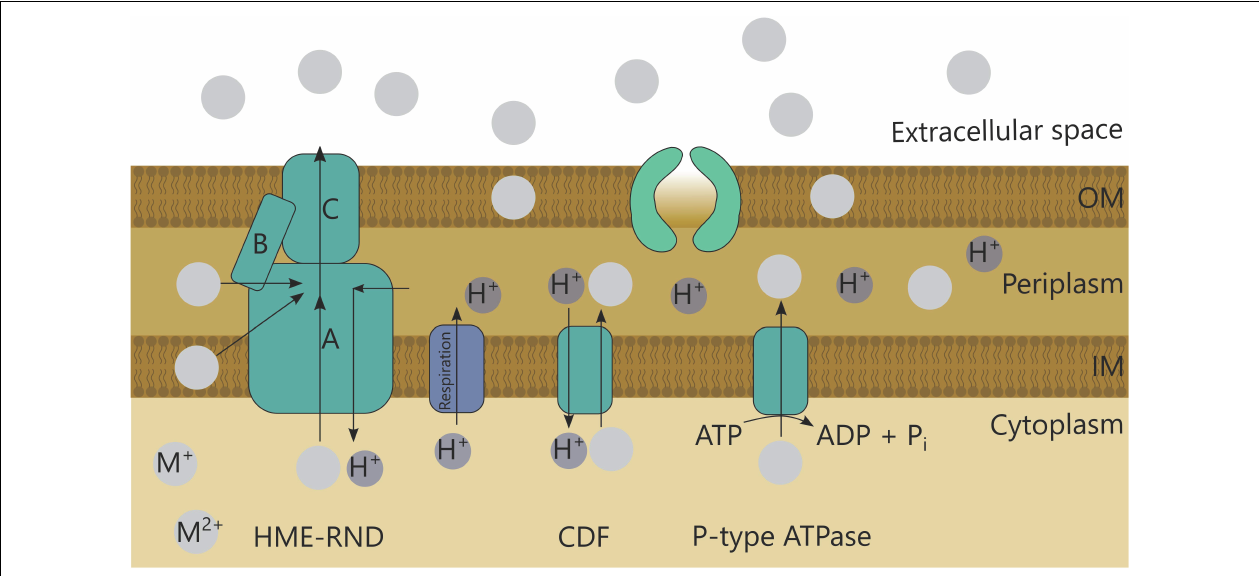
FIGURE 3 | Overview of bacterial efflux systems HME-RND, CDF, and P-type ATPase.